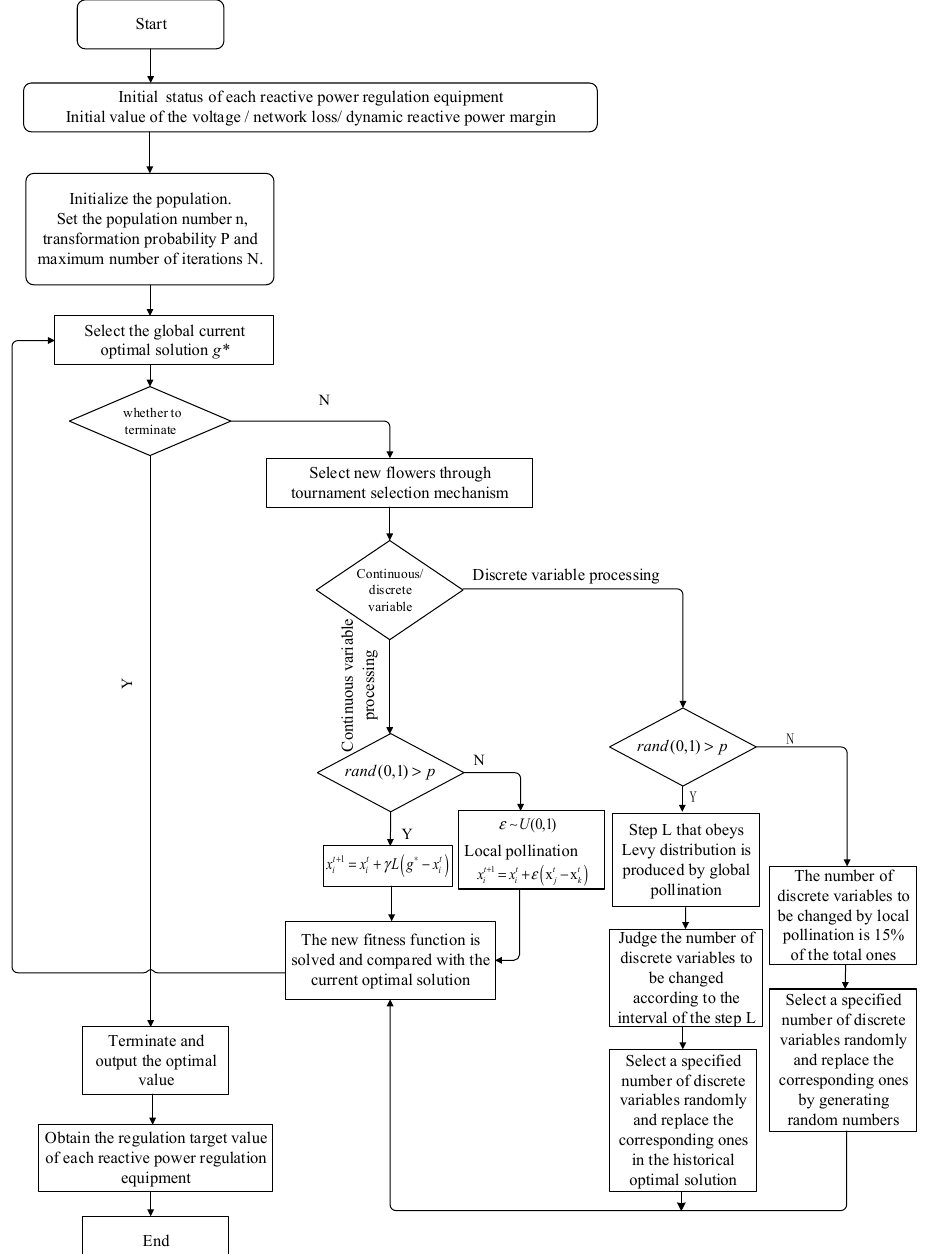
Figure 1. Flow chart of the reactive power and voltage optimization method based on improved continuous-discrete hybrid FPA.